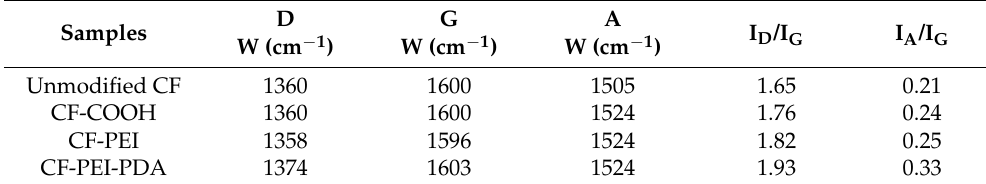
Figure 3. ( a ) Raman spectra for all CFs; the fitting Raman spectra for: ( b ) Unmodified CF. Table 1. Raman spectrum information of different carbon fibers.